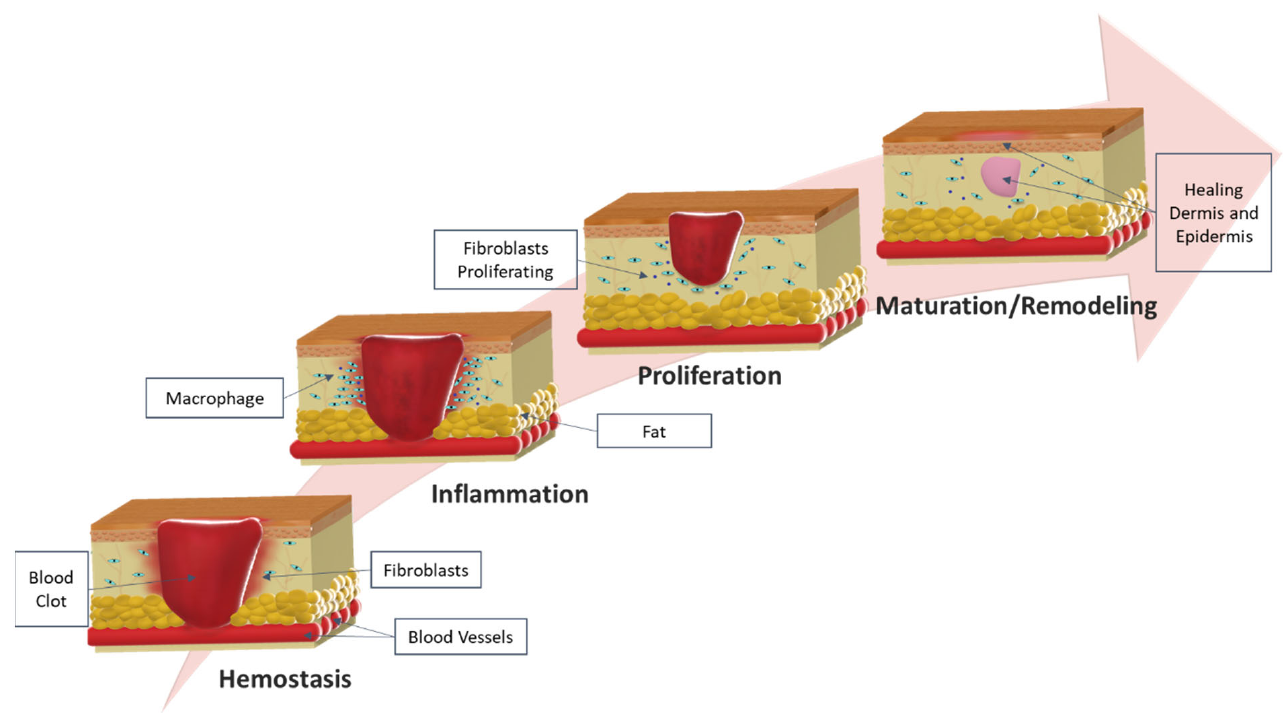
Figure 2. Schematic representation of wound healing stages (hemostasis, inflammation, proliferation and maturation/remodeling) and principal characteristics of each phase.